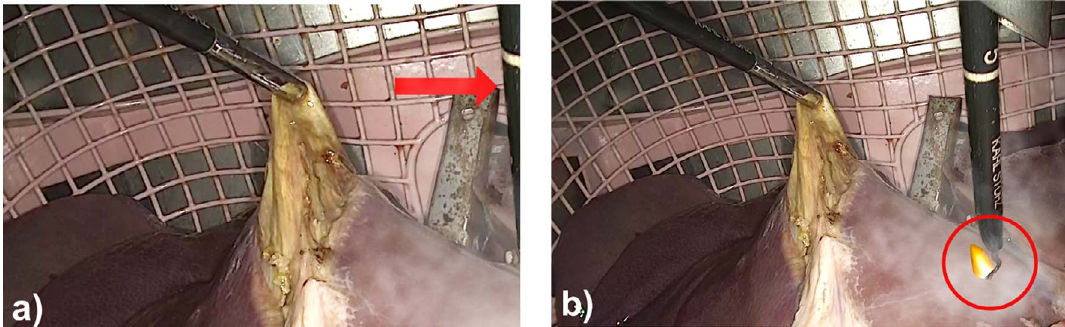
Figure 1. Electrosurgical instrument (red arrow) located near the right edge of the laparoscopic image section (a) and overview perspective (b) with visible instrument tip (potential electrical damage, red circle).